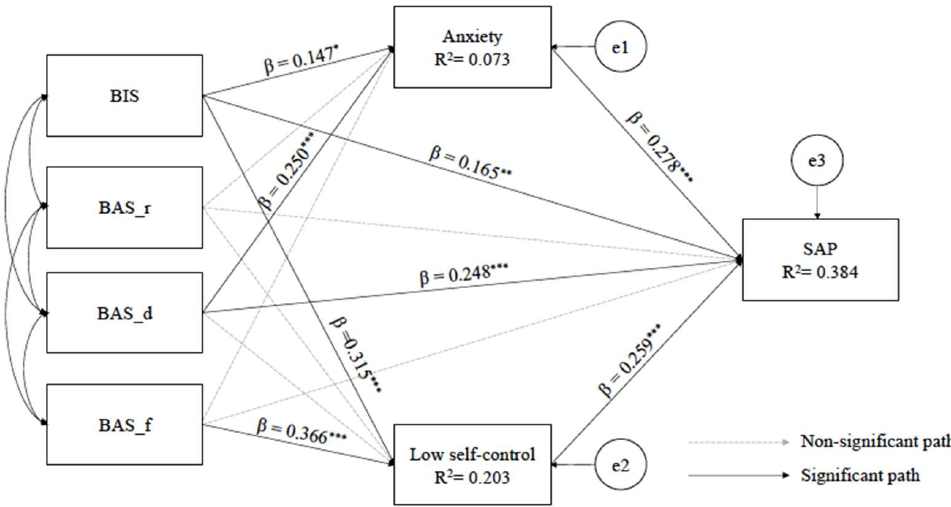
Figure 2. A path diagram of the study. Model fit statistics: χ 2 = 10.004, df = 6. Solid lines represent